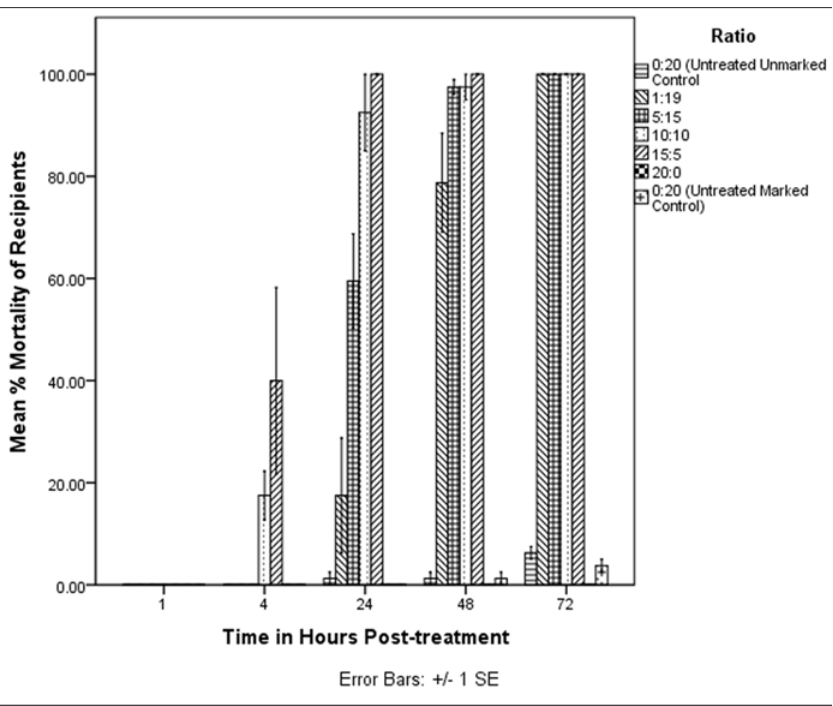
Fig. 9. Mean % mortality of recipient populations in varying cohorts of donor:recipient Reticulitermes flavipes termites through time when exposed for 30 minutes to soil treated with Termidor ® HE at 0.12%